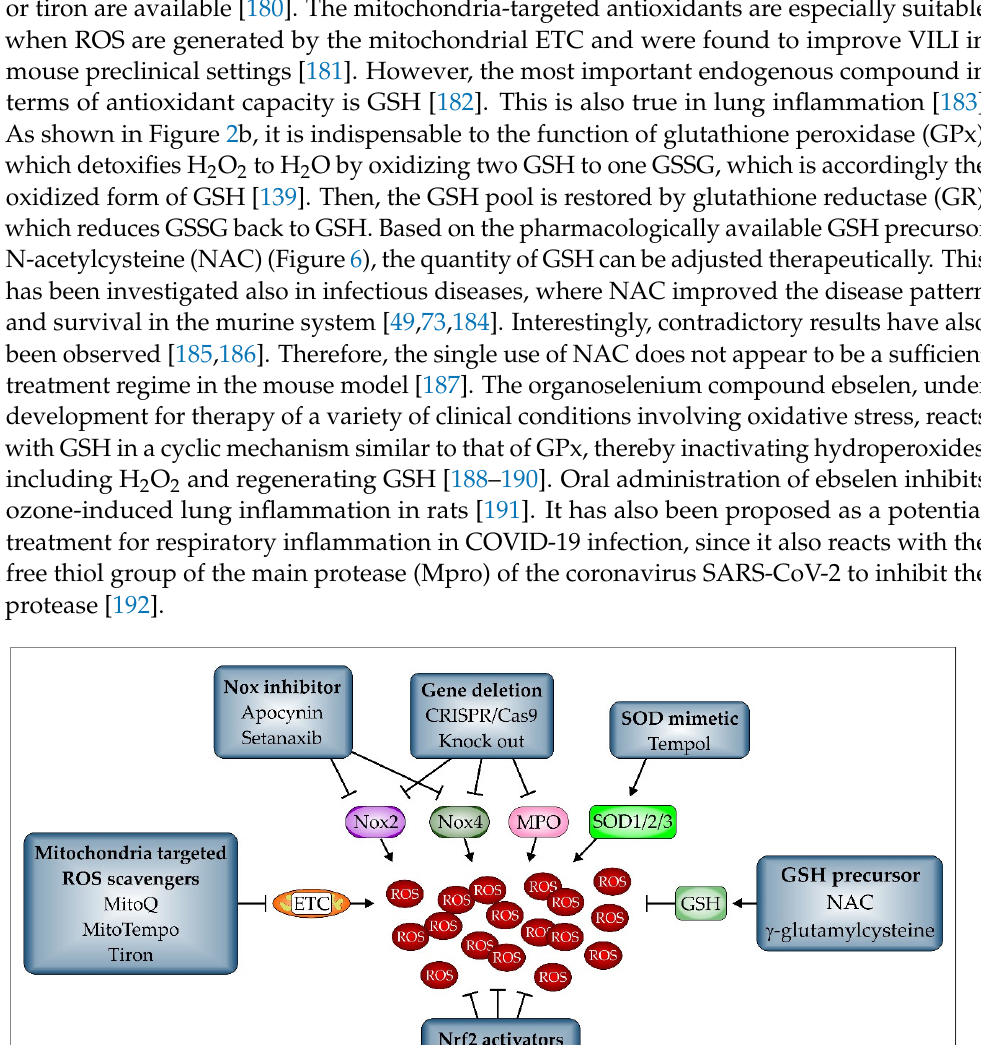
and-collar type transcription factor, nuclear factor erythroid 2-related factor 2 (Nrf2) [195]. Its expression is regulated under healthy conditions by Keap1, which targets Nrf2 for pro- teasomal degradation by the Cullin3/Rbx1 ubiquitination system [196]. Upon (electro- philic) oxidative stress, cysteines in Keap1 are oxidized and Nrf2 is released [196], conse- quently leading to its stabilization and subsequent induction of target gene expression [197]. In keeping with its role as a transcription factor, Nrf2 activates the expression of factors involved in detoxifying ROS, such as glutamate-cysteine ligase catalytic subunit (GCLC), glutamate-cysteine ligase modifier subunit (GCLM), GPx, GR, heme-oxygenase (HO-1), Prx, and SOD3 [197]. Thus, activation of Nrf2 leads to an antioxidative response, which is generally associated with an improved outcome of lung injury in mouse models [198]. In line with this, Nrf2-deficient mice show enhanced acute lung injury compared to wild-type mice following intestinal ischemia/reperfusion [199]. Considering that Nrf2 binds to antioxidative-response elements (AREs) in the promoter regions of target genes, their activation can also be followed in an ARE-reporter mouse, where the ARE site has